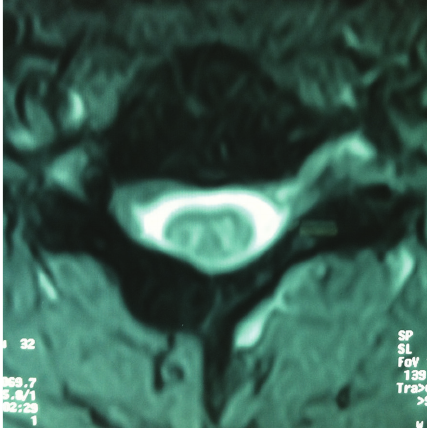
Figure 2: Mild expansion on the lamina of C5 vertebra and hypointense sclerotic lesion seen on T2 weighted MRI image.